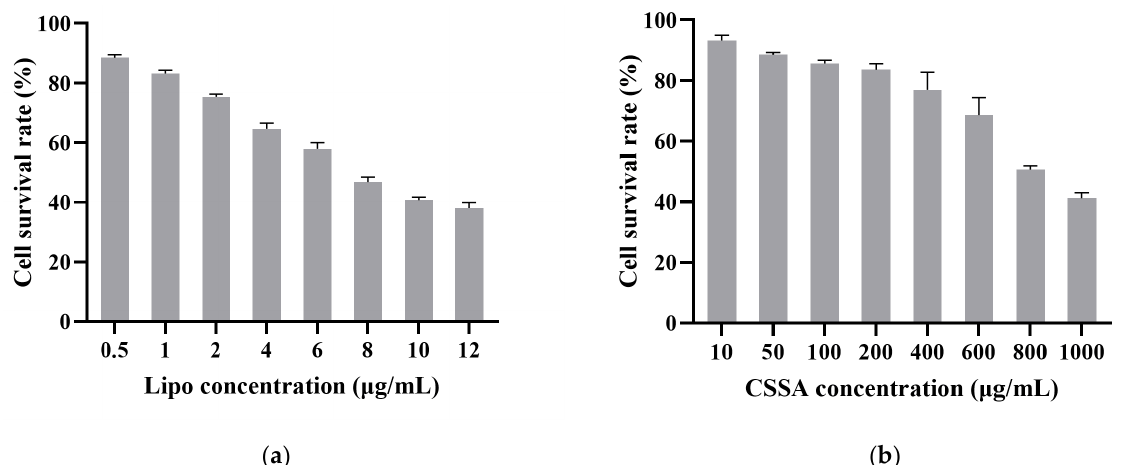
Figure 3. Cytotoxicity of Lipo ( a ) and CSSA ( b ) against Hep-2 cells (n = 3).